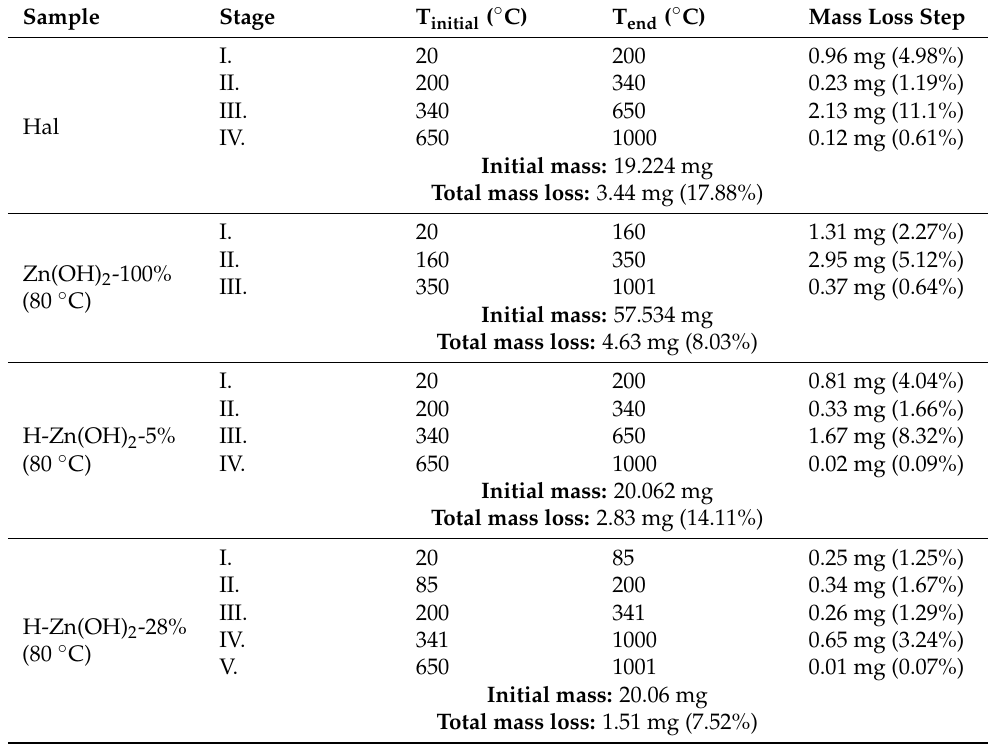
Figure A2. Infrared spectra of the investigated precursor samples in the 4000–400 cm − 1 spectral region. The bands of the as-prepared Zn(OH) 2 sample are indicated. Table A2. Thermoanalytical data readouts from Figure 5.